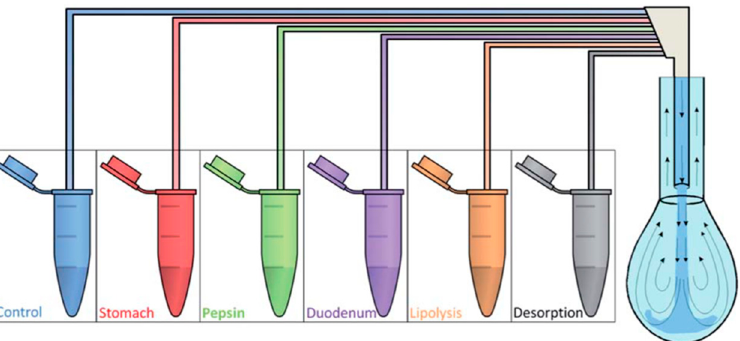
Figure 10. A schematic representation of the in vitro digestion procedure using the OCTOPUS setup based on a multiple-exchange protocol for the droplet subphase; reprinted with permission from [106].